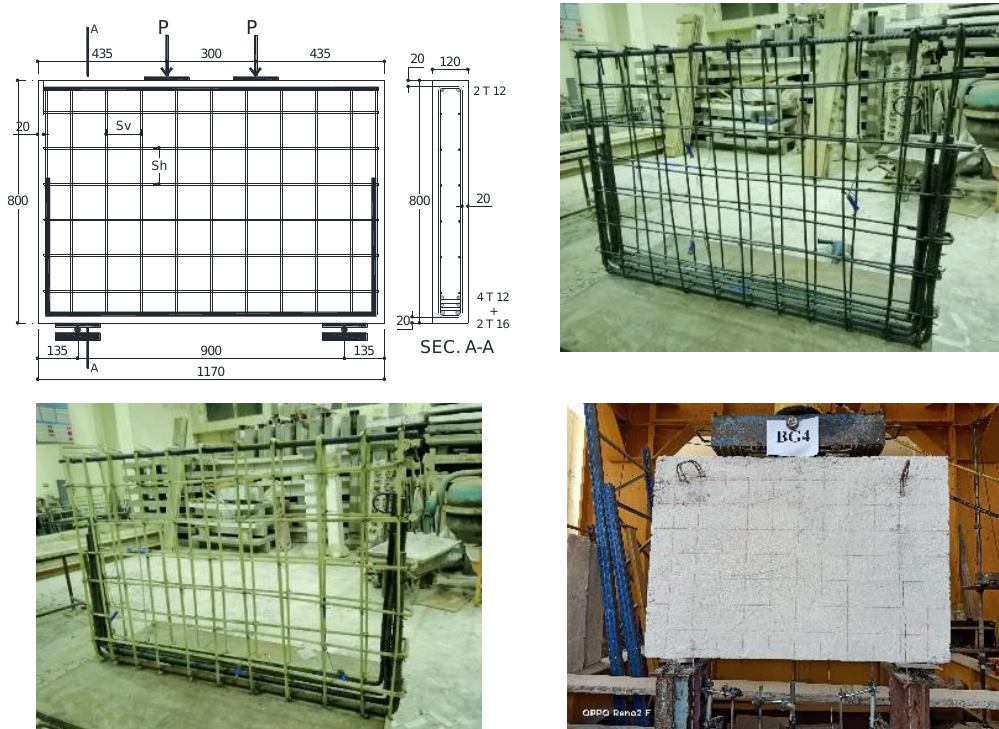
Figure 1: Details of a typical